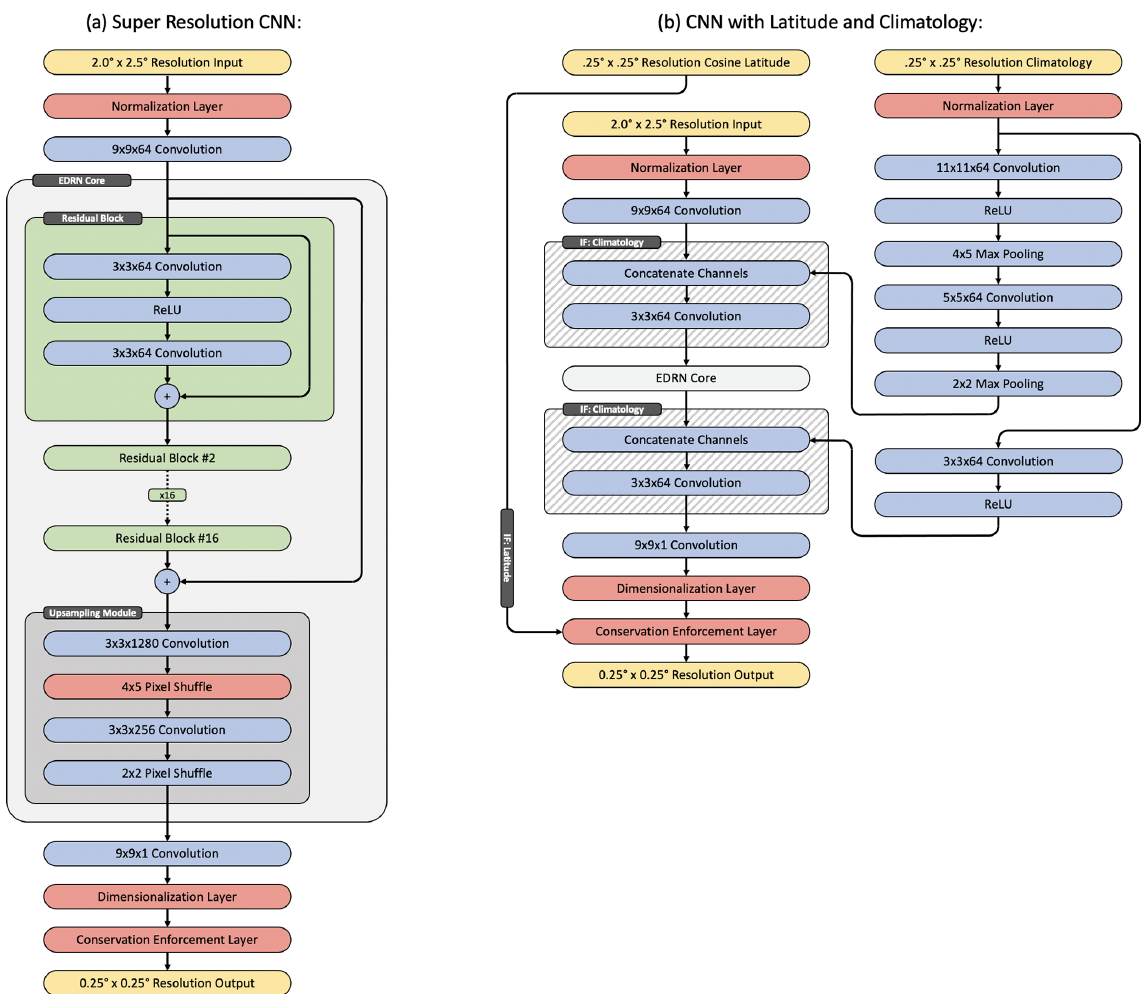
Figure 1. Diagram of the CNN architecture. Yellow cells denote input and output tensors, blue cells are commonly used Keras layers, red cells denote custom implemented layers, green cells represent residual blocks, and hashed cells denote layers that are conditionally on or off depending on whether climatological data are being